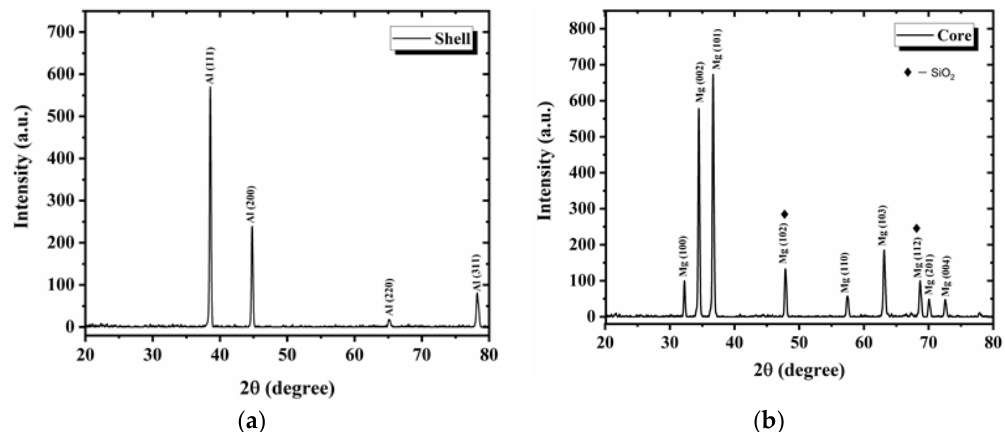
Figure 3. XRD patterns of the as-cast ( a ) pure Al (shell) and ( b ) Mg-20GMB material (core).